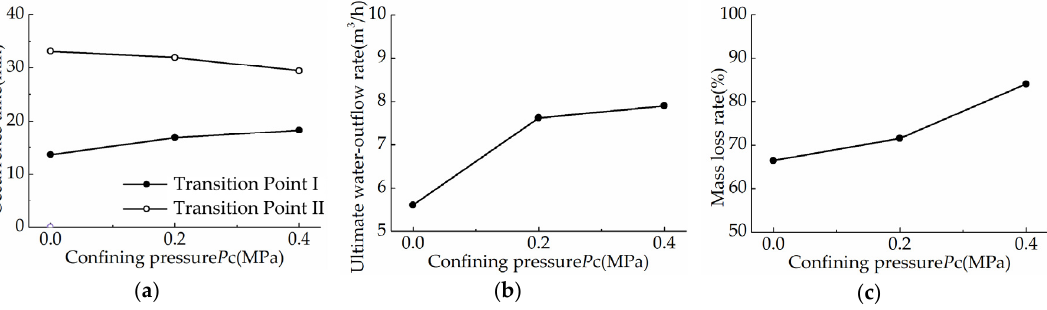
Figure 14. Variation tendency of monitoring objects’ characteristic value with confining pressure ( P c ). (a) Occurrence time of Transition Point I, II along with confining pressure; (b) Ultimate water-outflow rate along with confining pressure; (c) Mass loss rate along with confining pressure. Table 9. Variation of monitoring objects’ characteristic value with confining pressure ( P c